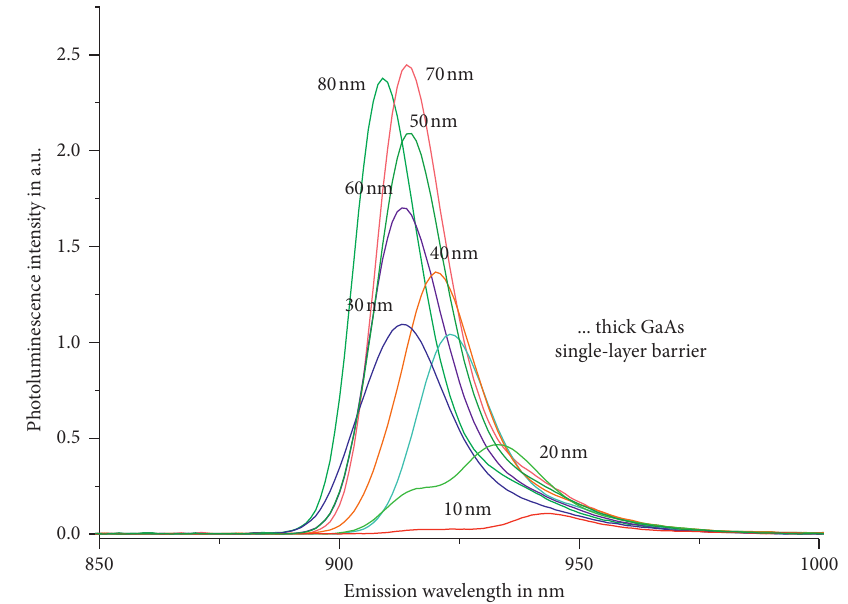
Figure 6: Results of photoluminescence (PL) measurements for different samples, each with 4 QD layers, but different GaAs single-layer barrier thickness. The QD layers have been grown with a V/III flux ratio of 1 :1, a substrate growth temperature of 530 ° C, and a nominal coverage of 3ML. The base width of these QDs is 25nm, and their height is 3 nm. For typical As-content, refer to Figure